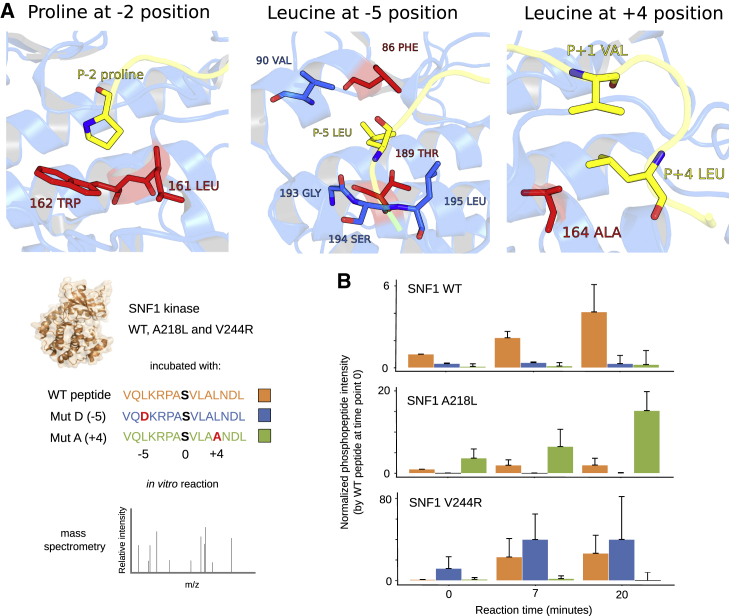
Structural Rationale for Kinase SDRs and Validation Experiments(A) Kinase-substrate interface for: proline at position −2 (PDB: 2WO6), leucine at position −5 (PDB: 3IEC), and leucine at position +4 (PDB: 3IEC) (Nesić et al., 2010; Soundararajan et al., 2013). The substrate peptides are in yellow and putative SDRs in red. A structural rationalization for each preference is provided briefly in the main text Structural characterization of kinase SDRs, and in Figure S3.(B) Kinase activity assays for Snf1 wild-type (WT) and 2 mutant versions A218L (the 164 kinase domain position, an L+4 SDR) and V244R (the 189 kinase domain position, an L-5 SDR). The 3 kinases were incubated separately with a known Snf1 target peptide with L at +4 and −5 (orange), as well as the mutant versions A+4 (green) and D-5 (blue). Replicates of in vitro reactions were quenched at 0, 7, and 20 min, and the amount of phosphorylation was measured by mass spectrometry. For each kinase and time point, the phosphopeptide intensity relative to the WT peptide at time point zero was calculated, and the median and standard deviation of 3 biological replicates were plotted.